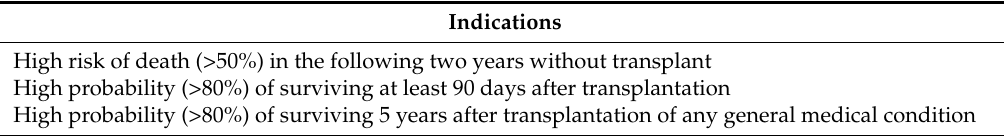
Table 1. Indications and contraindications of lung